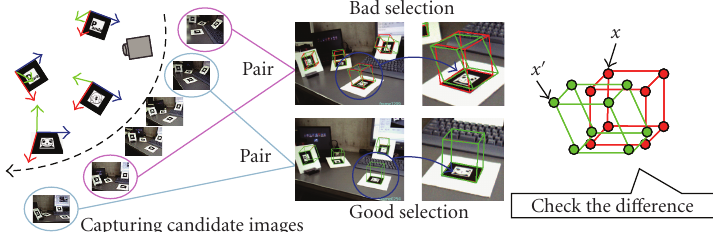
Figure 5: Automatic selection method of the reference images.